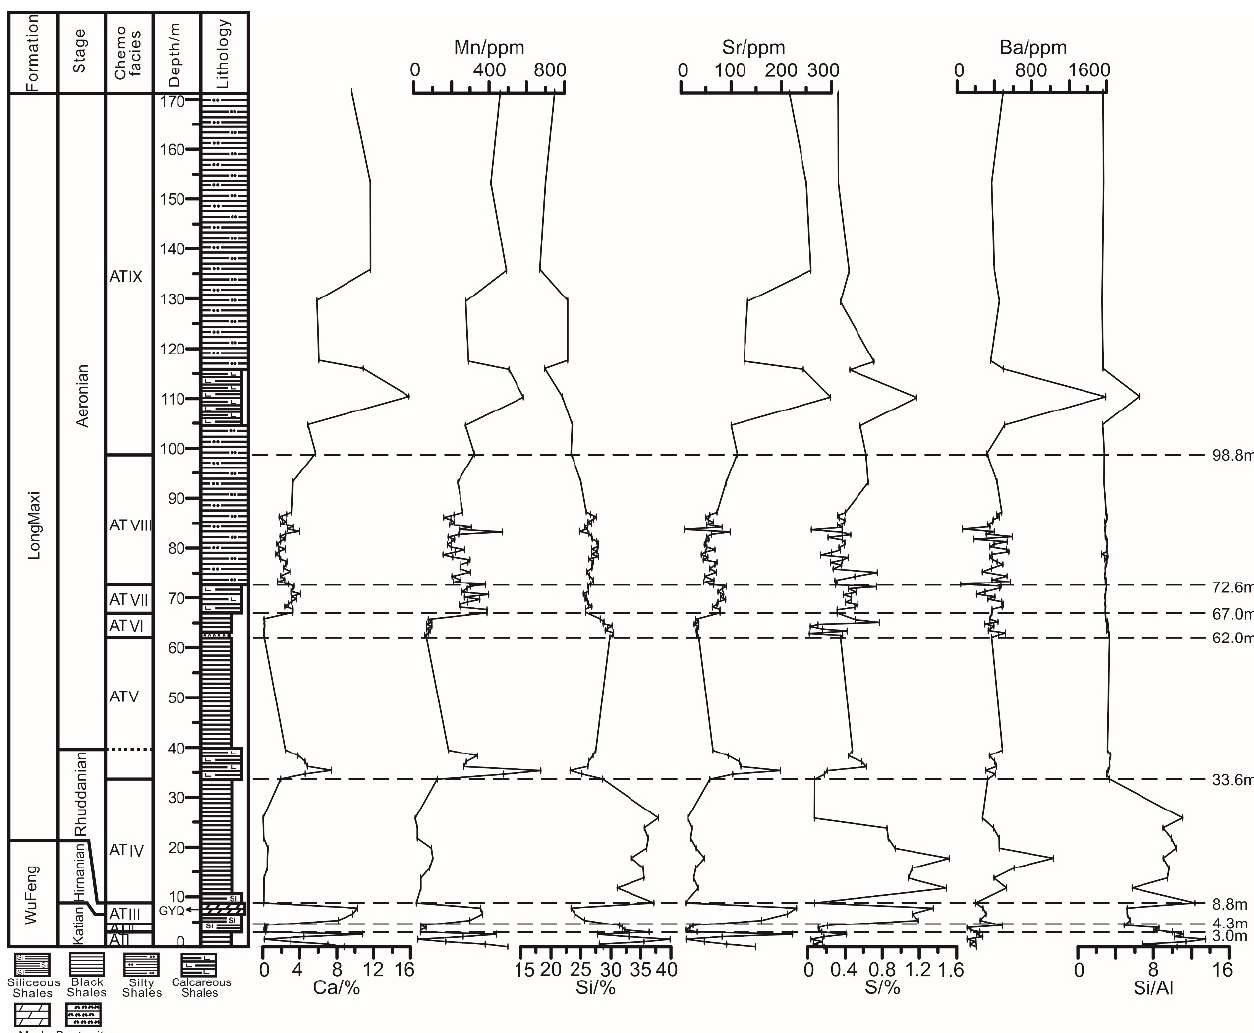
Figure 4. The chemozonation based on authigenic chemofacies of the Changning section. (3) The target succession of Wufeng and Longmaxi Formations was partitioned into five chemozones according to the variation of the redox-organic element association, i.e., RO Ⅰ (0 m–3.0 m), RO Ⅱ (3.0 m–4.3 m), RO Ⅲ (4.3 m–8.8 m), RO Ⅳ (8.8 m–33.6 m) and RO Ⅴ (33.6 m–170 m) (Figure 5).